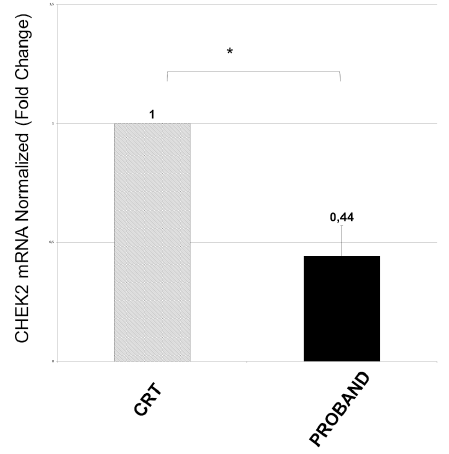
Figure 6. q-PCR analysis. Quantitative analysis of CHEK2 cDNA from the proband showed a value of 0.44 fold change to that of a control (CRT). β -actin was used for normalization. Statistical analysis was performed using the Student’s T-tail test; * p < 0.05.